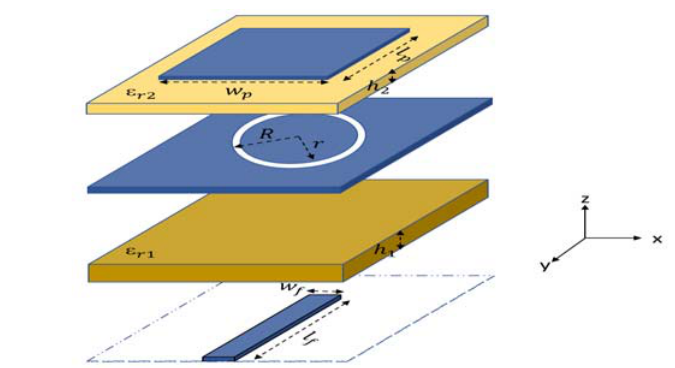
Fig 3. ASP (aperture-stacked patch) microstrip antenna designed with circle slot, The dimensions are 𝑙 (cid:3043) (cid:3404) 5.43 𝑚𝑚, 𝑤 (cid:3043) (cid:3404) 4.83 𝑚𝑚 , ℎ (cid:2869) (cid:3404) 0.5 𝑚𝑚 , ℎ (cid:2870) (cid:3404) 0.254 𝑚𝑚 , 𝑤 (cid:3033) (cid:3404) 0.58 𝑚𝑚, 𝑙 (cid:3033) (cid:3404) 7.147𝑚𝑚 ,  (cid:3045)(cid:2869) (cid:3404) 3 ,  (cid:3045)(cid:2870) (cid:3404) 1.